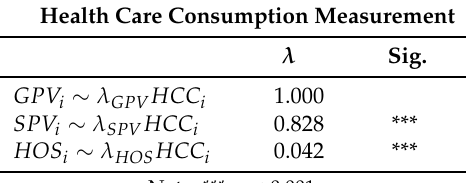
Table 7. Results for the measurement of health care consumption (Equation (3)).